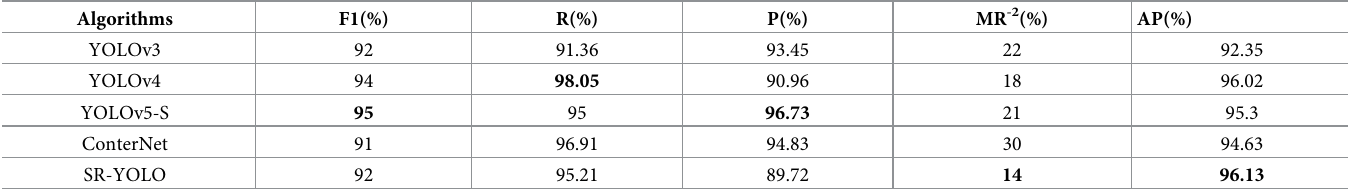
Table 5. Comparative experiment of multiple networks on UCAS-AOD dataset (IOU 0.5). Algorithms